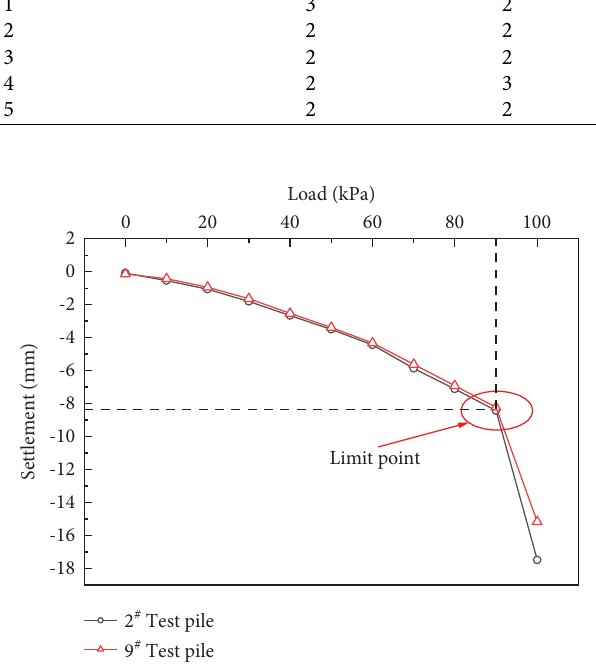
Figure 9: Test pile load-settlement curves for single piles No. 2 and 9.